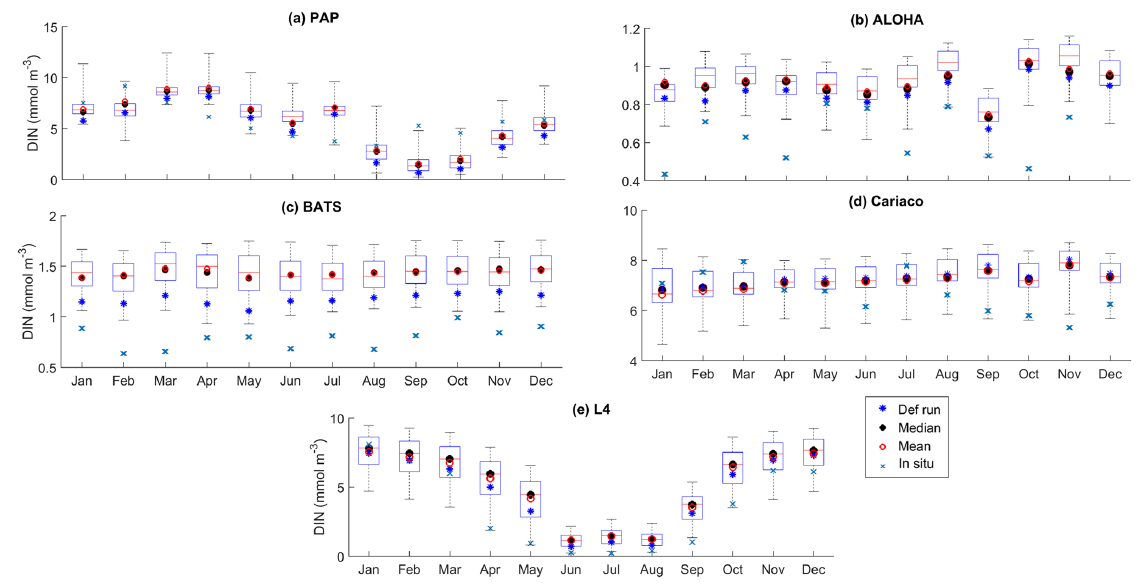
Figure 7. The 10-year monthly mean of DIN averaged over 200m from all the study sites ( a – e ), showing the seasonal dynamics of DIN (mmolm − 3 ). For station PAP, the DIN shown is the overall profile, and in L4 the in situ DIN concentration is only available at the surface. The box plot shows the ensemble monthly means. The blue cross is the in situ observation; the red open circle, black dot, and blue stars are the ensemble mean, median, and the default run respectively. The blue box is the 75th and 25th quartiles. The red line is the median. The whiskers are the ensemble minimum and maximum mean of averaged DIN. In station PAP, the in situ data are only collected from 2002 to 2004 and L4 from 2000 to